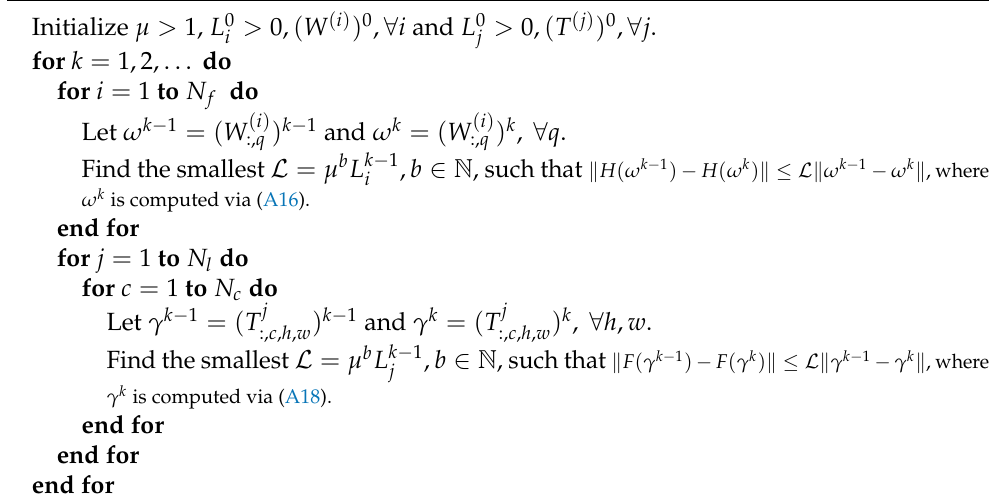
Algorithm A2 DNN_PALM Algorithm for (cid:96) 1 norm Group Lasso